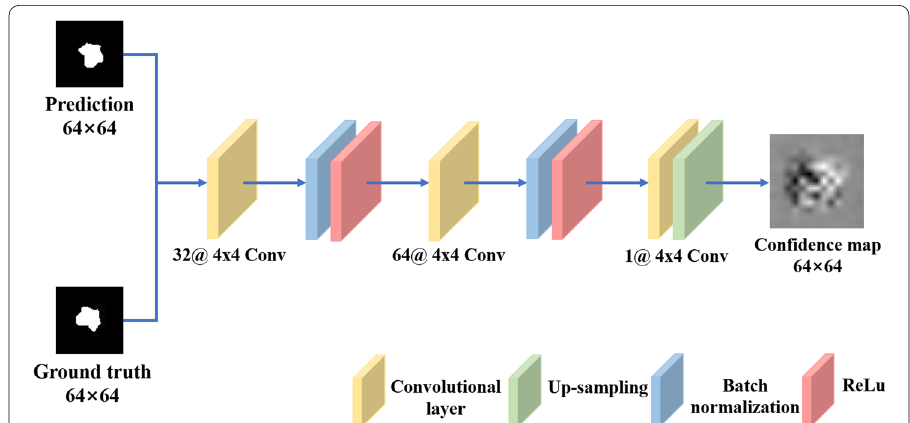
Fig. 7 The structure of discriminator which back propagates the segmentation modules. Discriminator takes the segmentation predictions from PDM and the ground truth as input